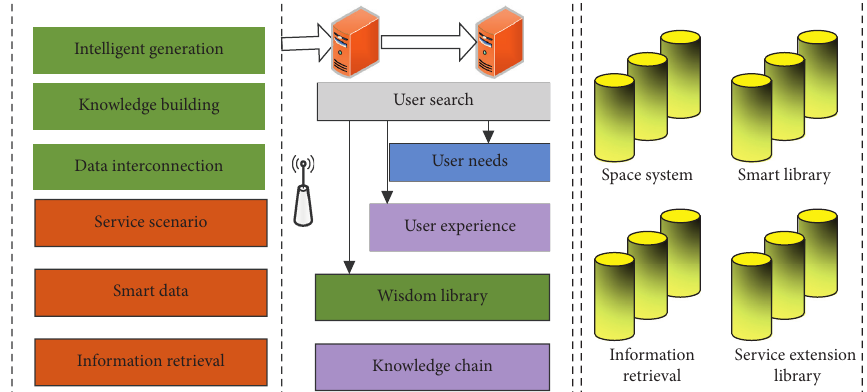
Figure 5: Mechanism model of endogenous power and user behavior of the extension of knowledge service in smart